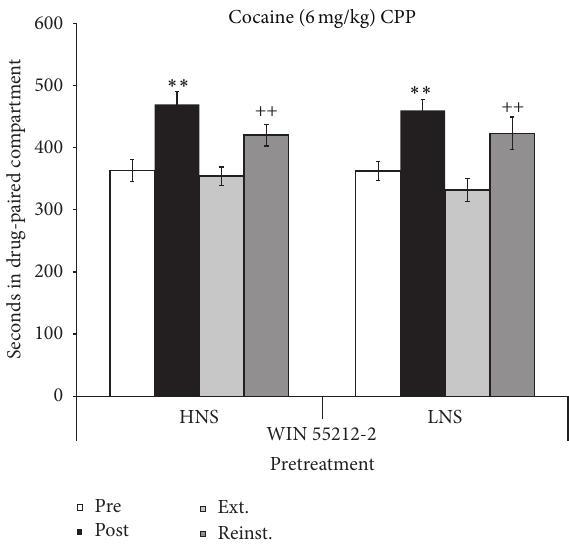
Figure 6: CPP induced by cocaine (6mg/kg) in HNS and LNS adolescent mice pretreated 6 days before initiation of conditioning with 0.1mg/kg of WIN 55212-2 (HNS, 𝑛 = 14 ; LNS, 𝑛 = 15 ). Bars represent time in seconds spent in the drug-paired compartment during preconditioning (white), postconditioning (black), the last extinction session (light grey), and reinstatement (dark grey). Values are mean ± SEM. ∗∗ 𝑝 < 0.01 , difference with respect to the preconditioning session. ++ 𝑝 < 0.01 , difference with respect to the previous extinction session.